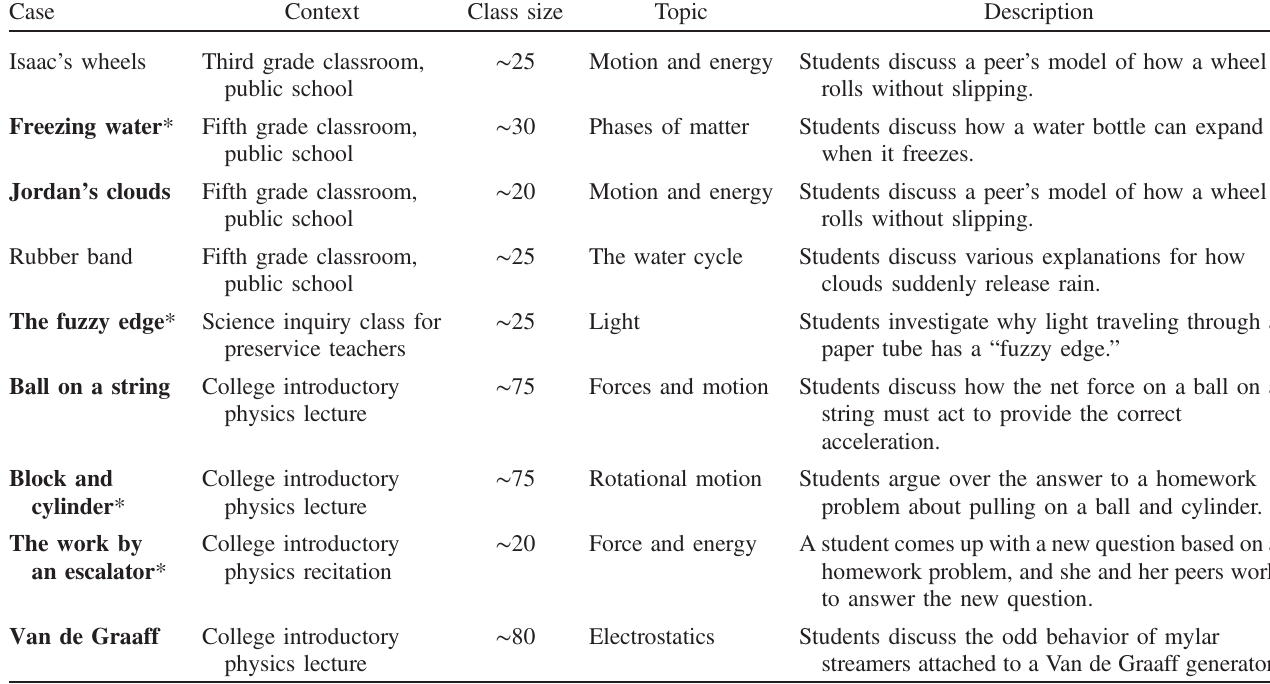
TABLE I. Our nine case studies. Problematizing was prominent in the dynamics in the cases in bold font. Starred cases are presented here and in the Supplemental Material